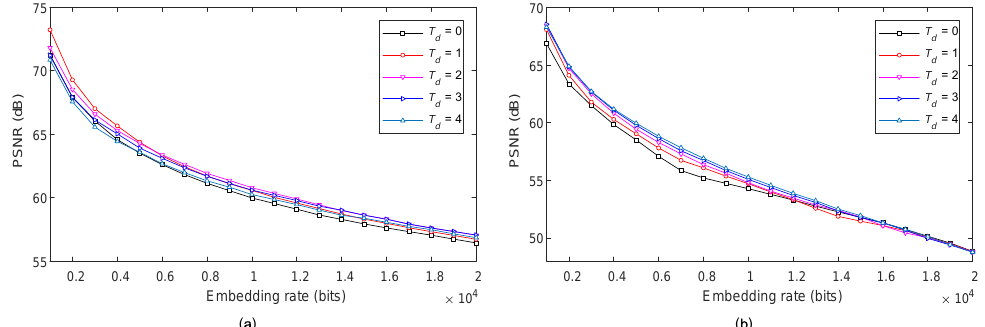
Figure 7. The payload-distortion performance due to small T d for the images Lena and Baboon : ( a ) Lena , ( b ) Baboon .